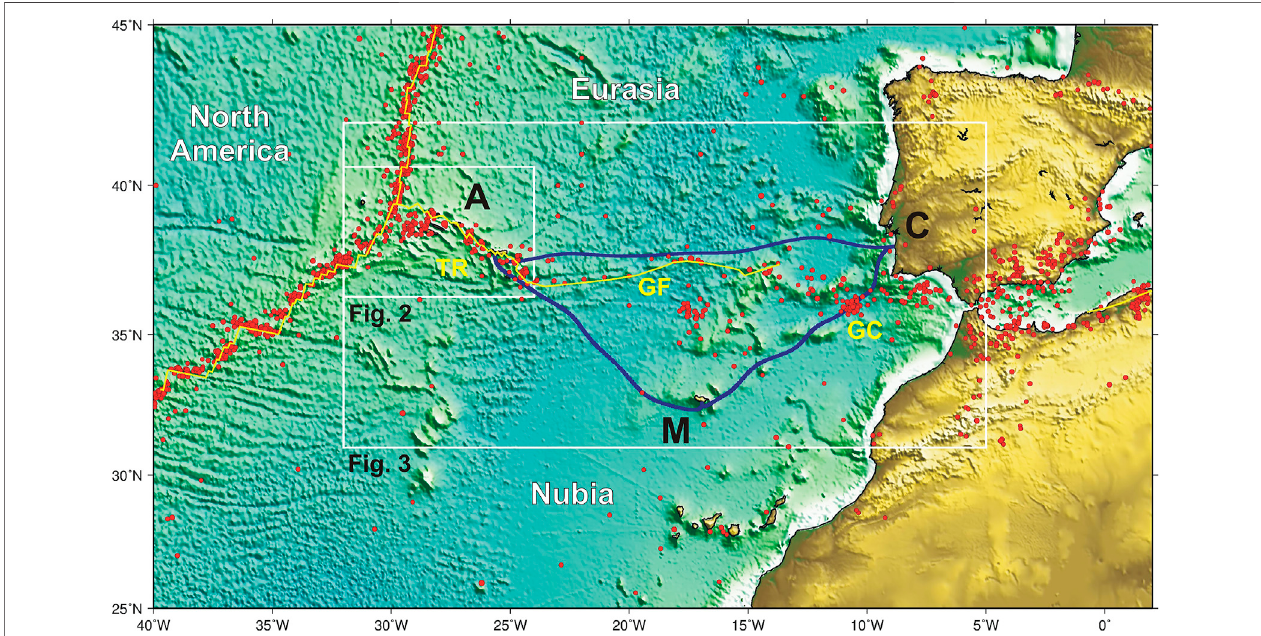
FIGURE 1 | Shaded bathymetry map of Iberia, northwest Africa and Central Atlantic (Smith and Sandwell, 1997). Solid yellow line: plate boundaries from Bird (2003).Whiteboxes,locationfor Figures2 , 3 .Smallredcircles:epicenters,fromISC,M > 4,1964 – 2018,http://www.ISC.ac.uk.GC:GulfofCadiz;GF:GloriaFault;TR: Terceira Ridge; C: Mainland Portugal; A: Azores archipelago; M: Madeira archipelago. Thick blue lines show the CAM submarine cables to be replaced by 2024.